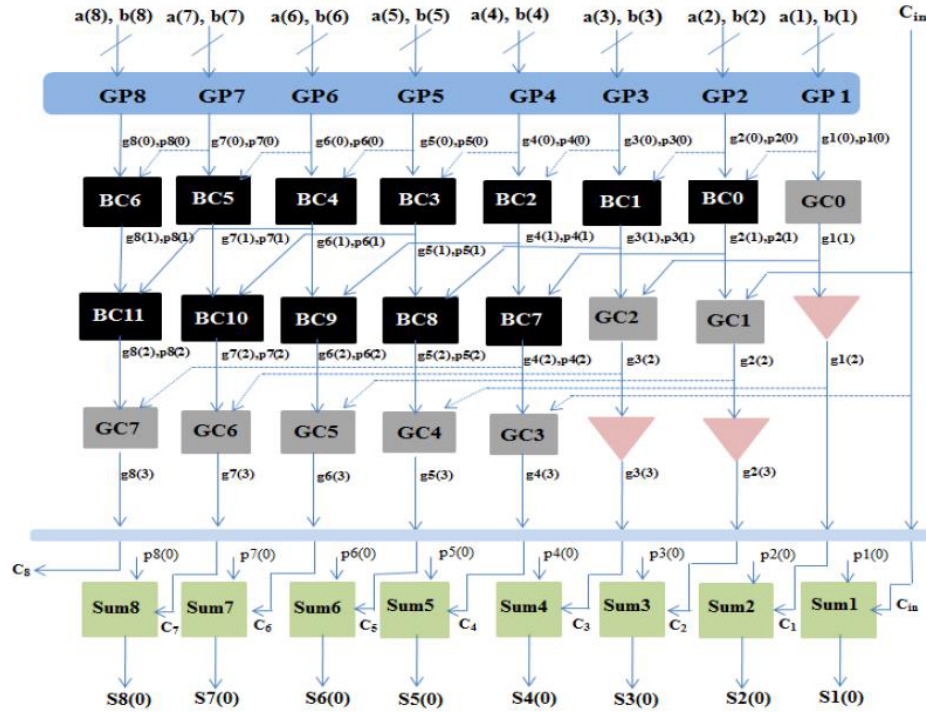
Figure 2. Kogge-Stone graph based on 8-bit Prefix adder